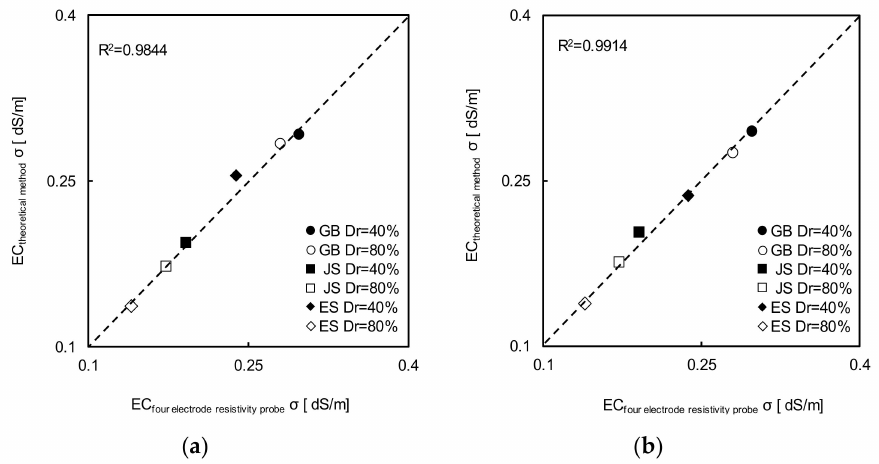
Figure 10. A comparison of the electrical conductivity deduced by 4ERP and the theoretical method based on: ( a ) Equation (11); ( b ) Equation (12). Note that EC denotes the electrical conductivity.